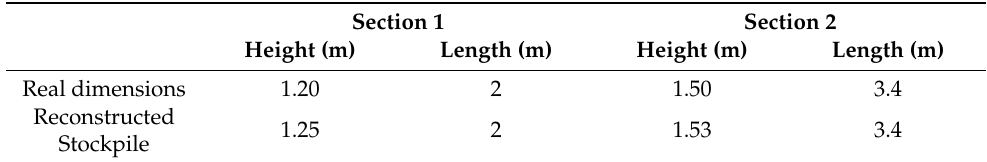
Table 1. Real and reconstructed dimensions of the stockpile.